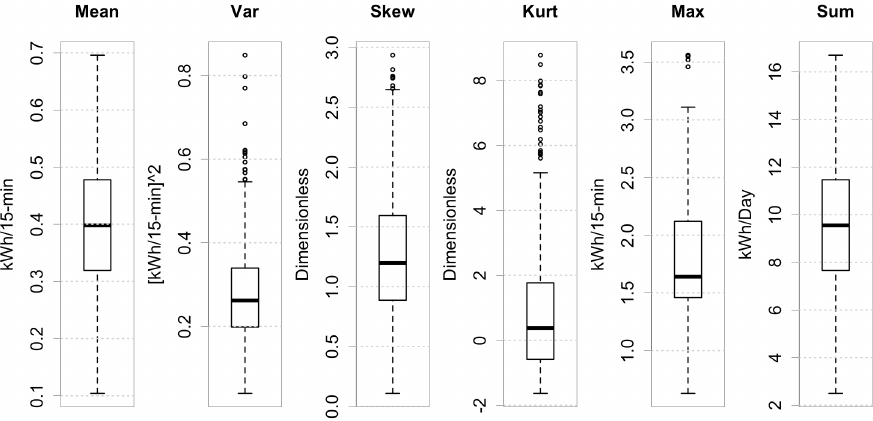
Figure 5. Electric DHW heater energy usage in RBSA home 10388 per 15-min interval and per day from Q2 2012–Q1 2013 inclusive. Usage is representative of observations of electric DHW heaters in other